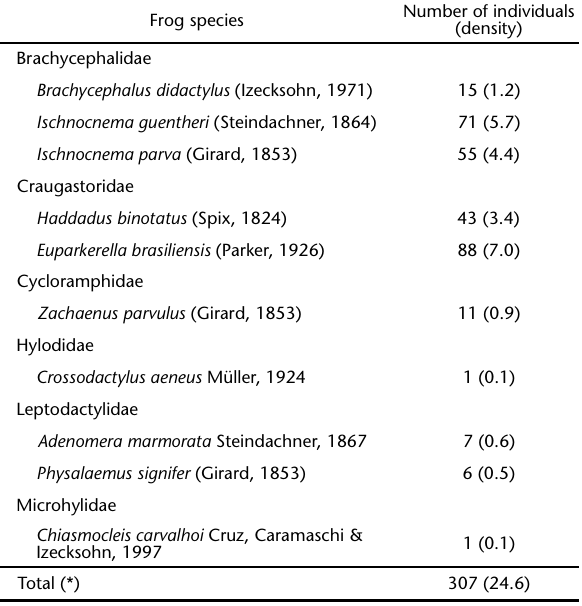
Table I. Total number of individuals sampled and estimated density (individuals/100 m 2 , in parenthesis) of each frog species found in the leaf-litter frog community of the Atlantic rainforest of Reserva Ecológica de Guapiaçu, southeastern Brazil, using 5 x 5 plot sampling method. (*) Nine individuals of unidentified species evaded